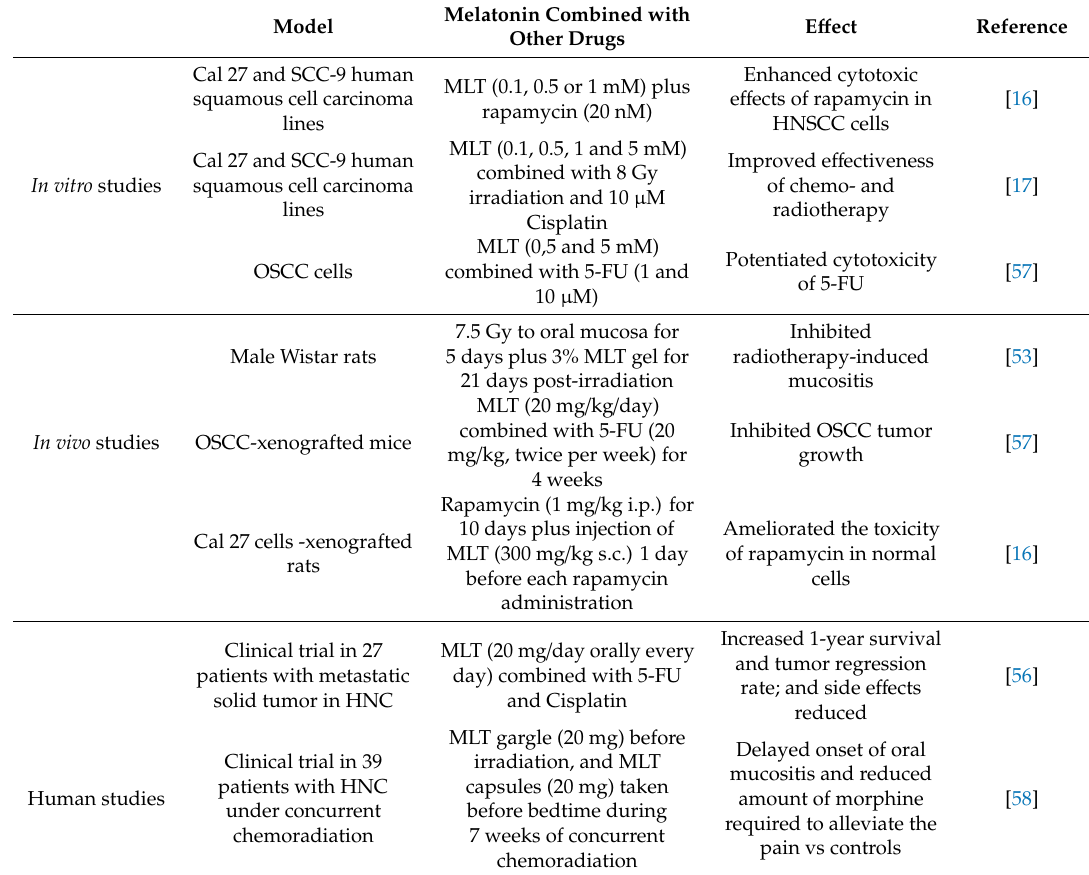
Table 1. Melatonin administration as an adjuvant for the management of oral cancer in vitro , in vivo and in human studies.